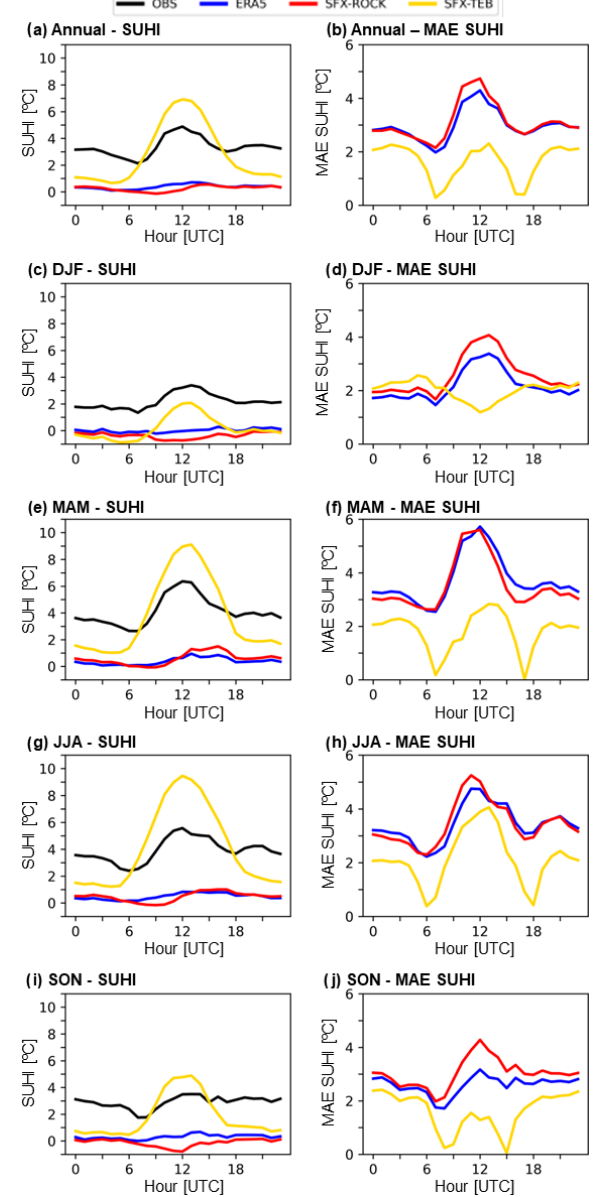
Figure 8. Average SUHI diurnal cycle computed over the 2004– 2018 period for (a) full year, (c) DJF, (e) MAM, (g) JJA, and (i) SON. The different colors represent LSA-SAF (black), ERA5 (blue), SFX-ROCK (red), and SFX-TEB (yellow). The respective | bias | diurnal cycles are represented for the (b) full year, (d) DJF, (f) MAM, (h) JJA, and (j) SON, using LSA-SAF as